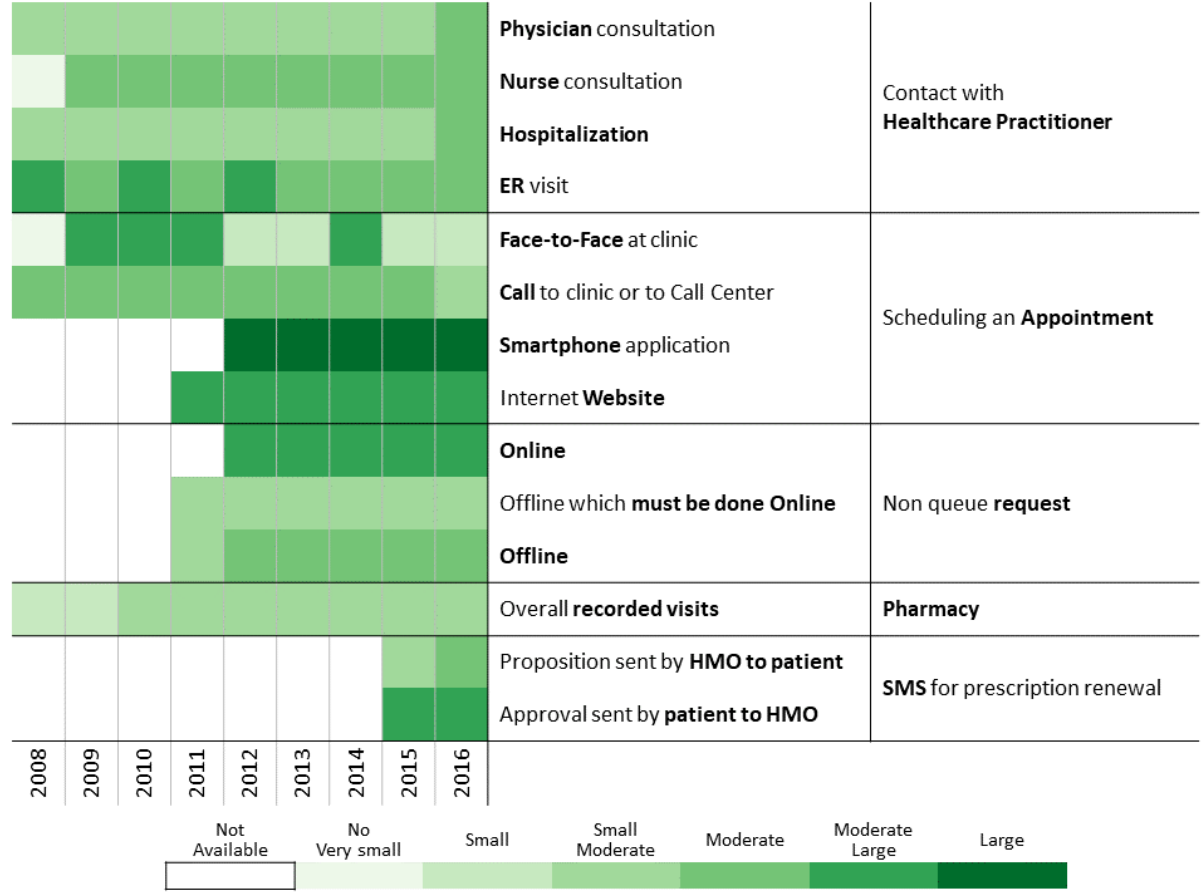
Figure 14. Communication pattern changes between 2008 and 2016 for patients with diabetes having a high volume of electronic contacts over the health management organization smartphone